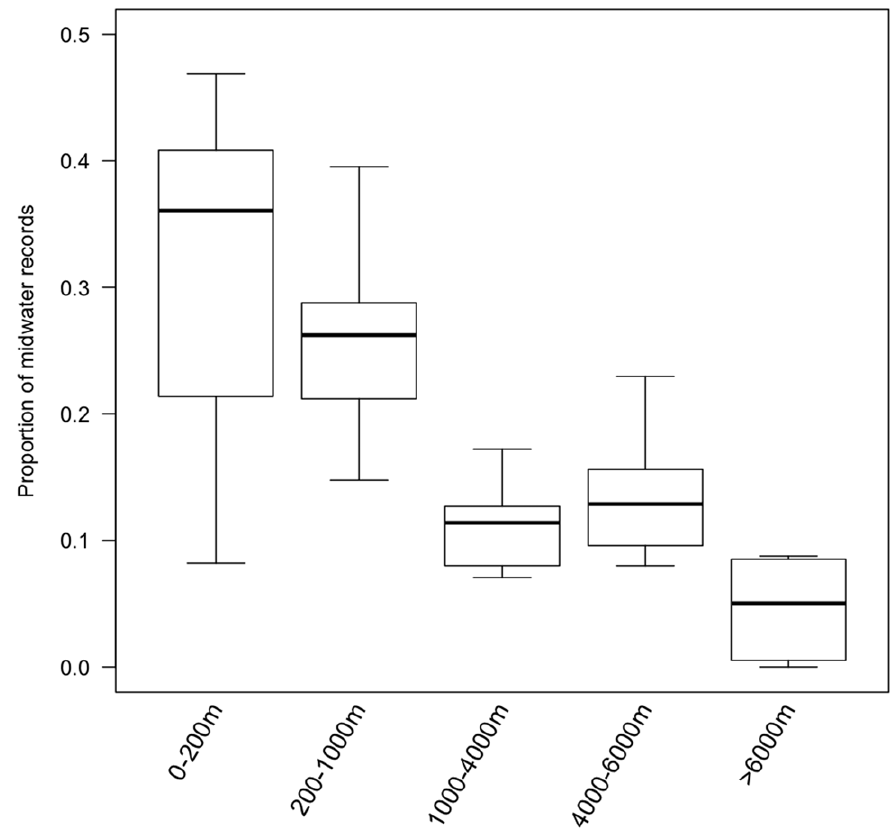
Figure 3. The proportion of recorded marine biodiversity originating from the midwater pelagic ecosystem. The ocean is split into the depth zones defined in Table 1. Midwater is defined as all of the water column except the 10m nearest the surface or the 10m (for the continental shelf) or 100m (for the mesopelagic continental slope) above the sea bed, and for the other ocean zones as the water column excluding the 100m nearest the surface and the 200m (for the bathypelagic zone and the abyssal plain) or 1000m (for the hadal zone) above the sea bed. For each zone, the plot shows the median, interquartile range and total range of observed proportions. The shallowest two depths (0—10m and 10—20m) are excluded, as there is no midwater according to our definition.